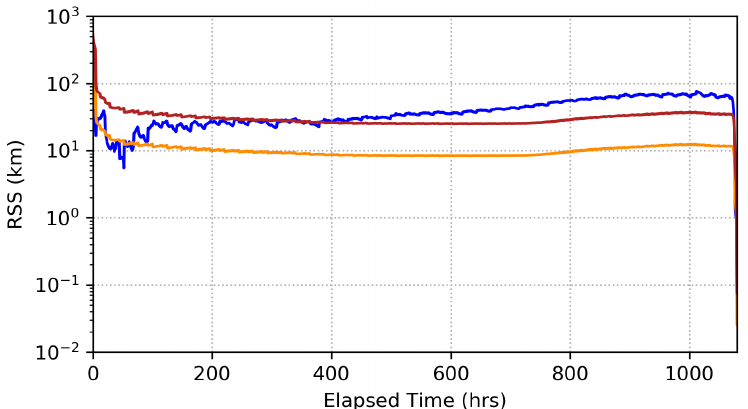
Figure 12. Position error (blue) and RTPC uncertainty (1- σ (orange) and 3- σ (red)) for radiometric-only filter in Large Radiometric Bias